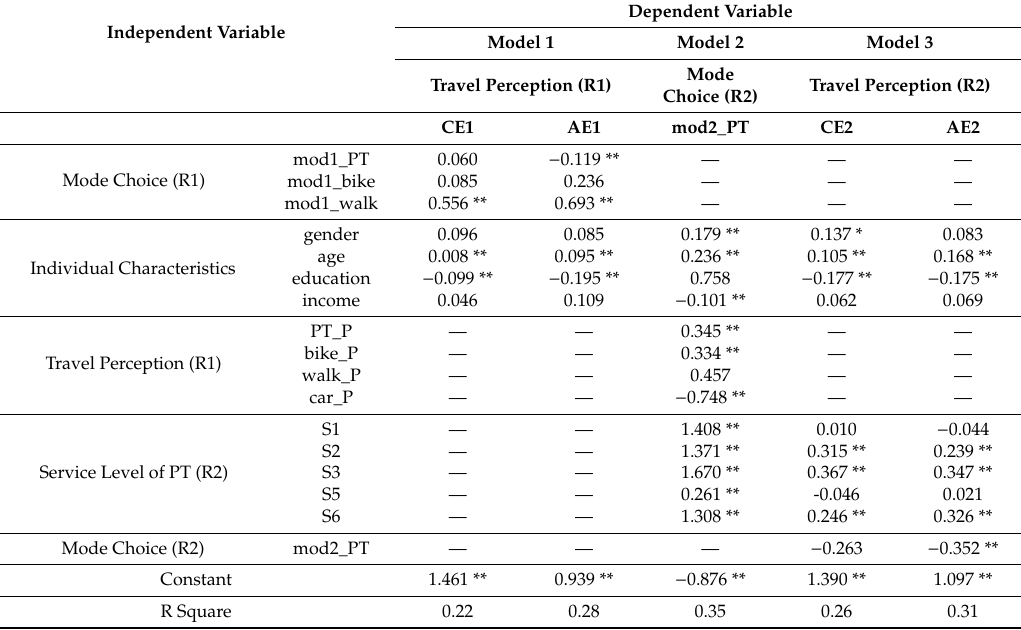
Table 9. Process model results of public transport service improvement (N =